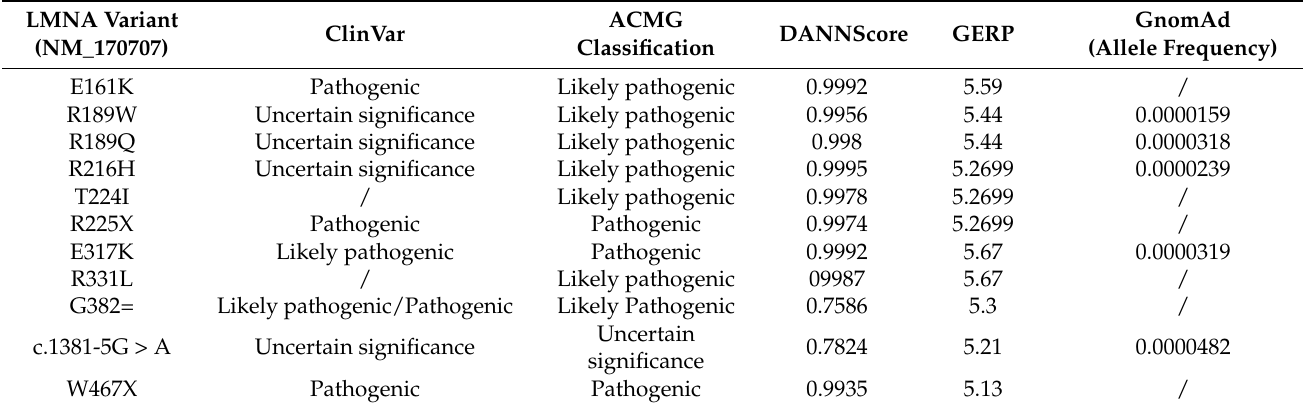
Table 2. Classification of LMNA variants